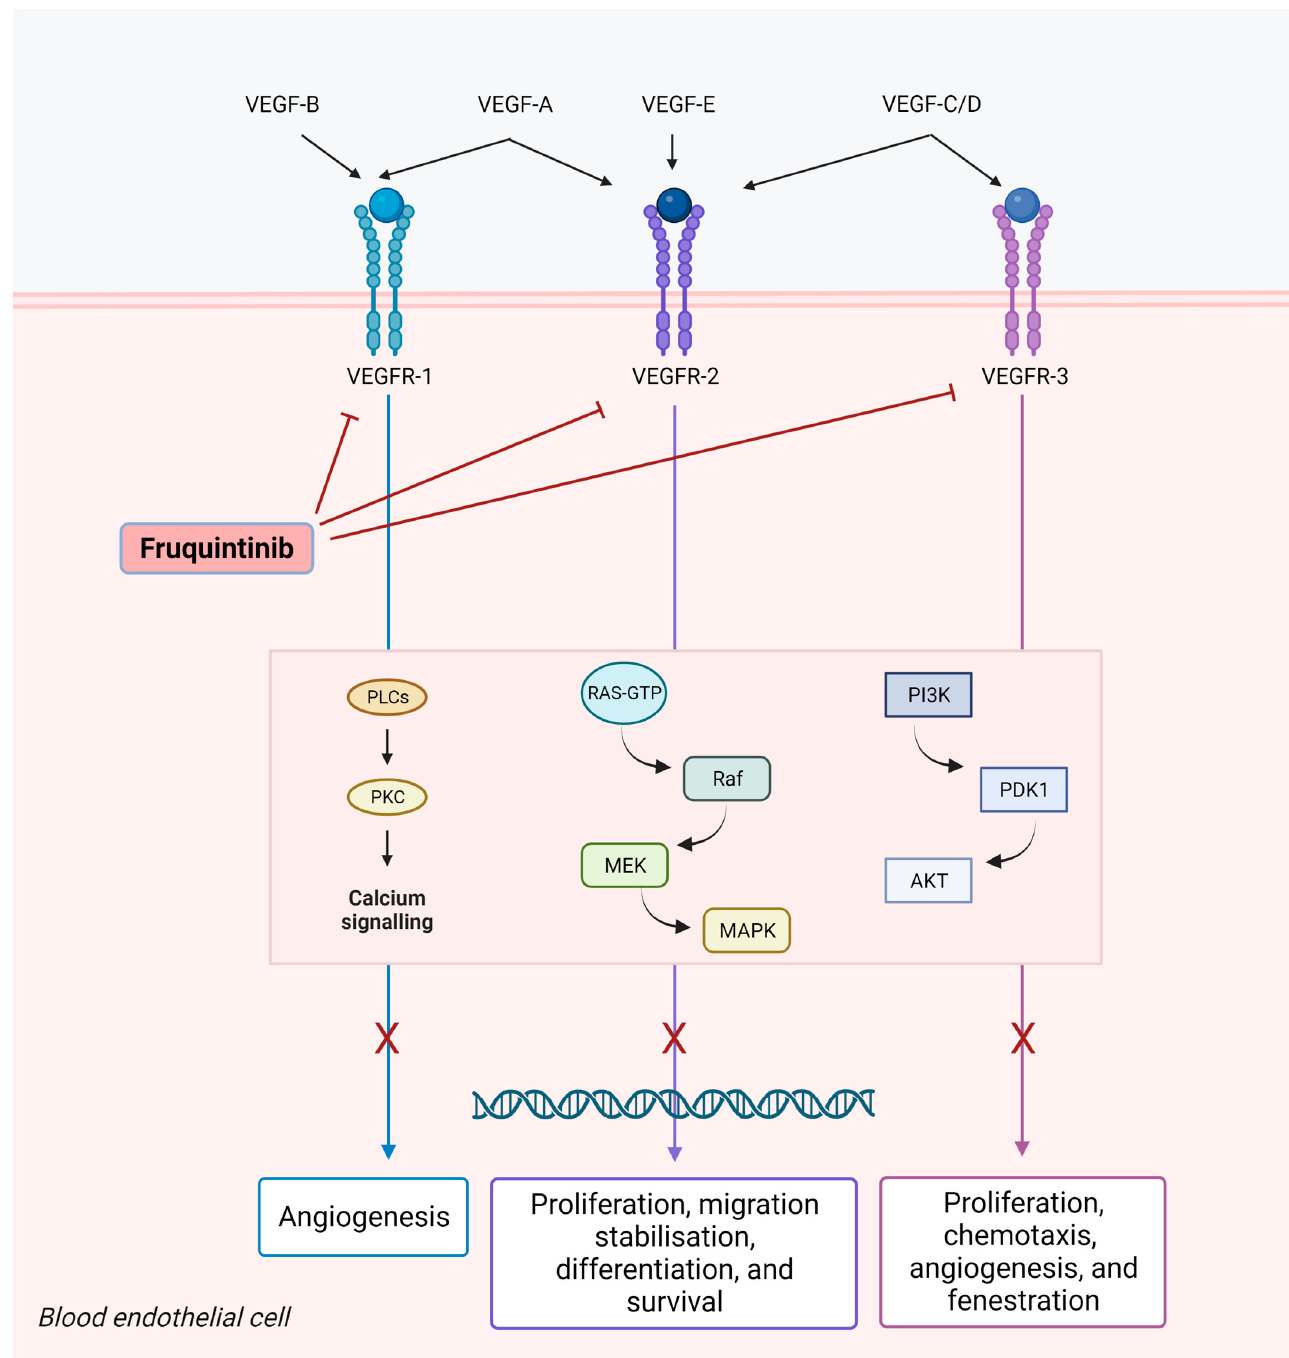
Figure 1. Fruquintinib inhibits vascular endothelial growth factor (VEGF)-induced phosphorylation of VEGF receptors 1, 2, and 3 and related signaling pathways. This may result in the inhibition of migration, proliferation, and survival of endothelial cells, micro-vessel formation, the inhibition of tumor cell proliferation, and tumor cell